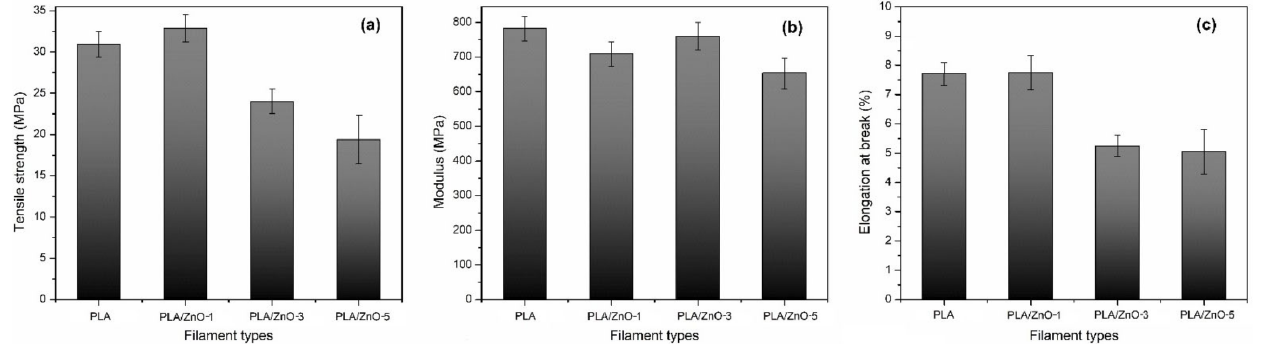
Figure 7. Effect of varying ZnO nanoflower contents on the mechanical properties: tensile strength ( a ), modulus strength ( b ), and elongation at break ( c ), of PLA and PLA/ZnO biocomposite